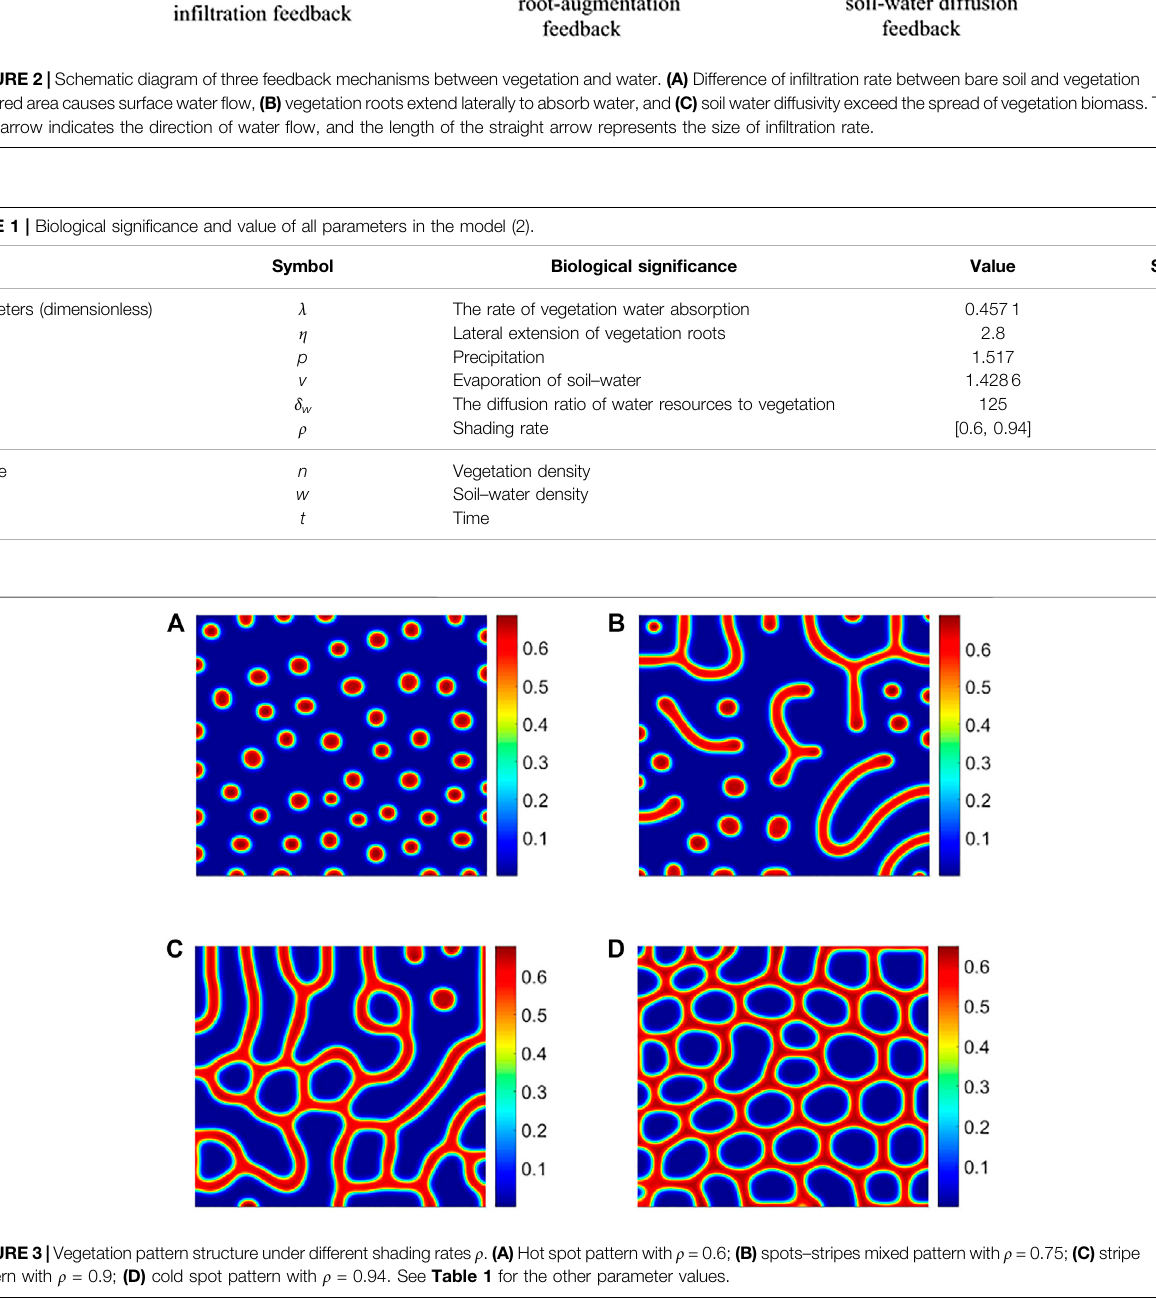
Frontiers in Physics |